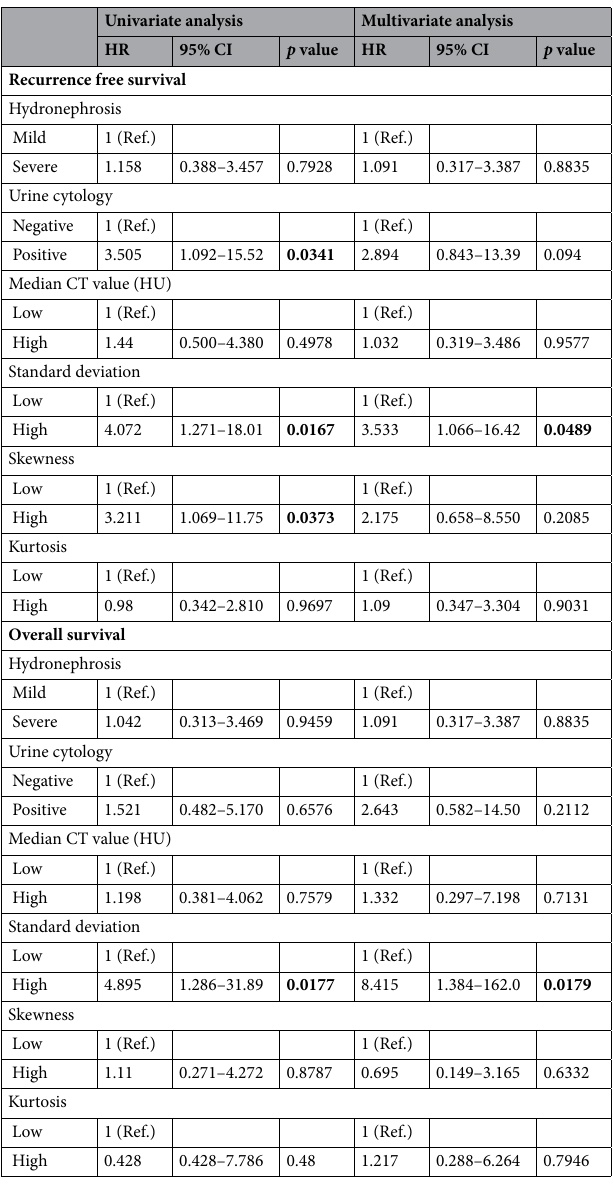
significance of bold means p <